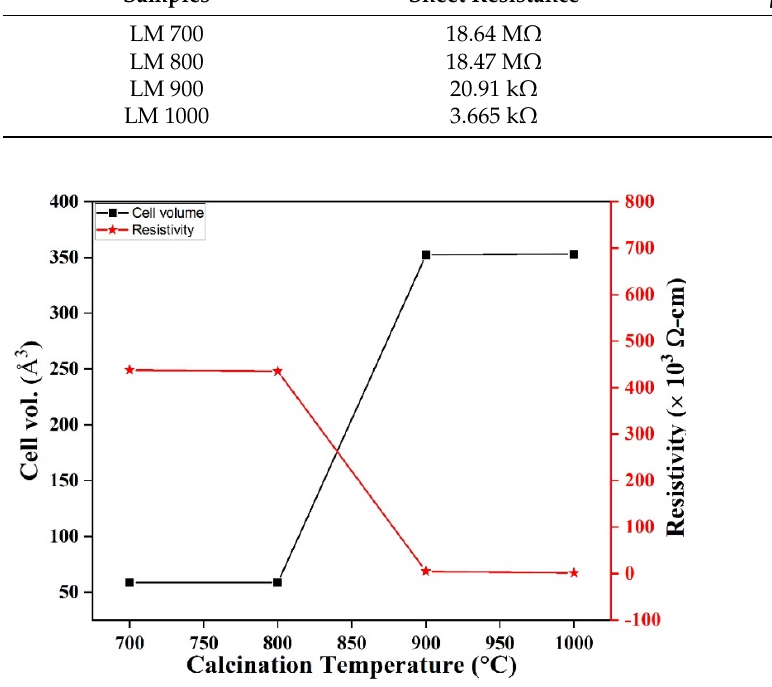
Figure 8. A plot of the cell volume and resistivity of LaMnO 3 calcined at different